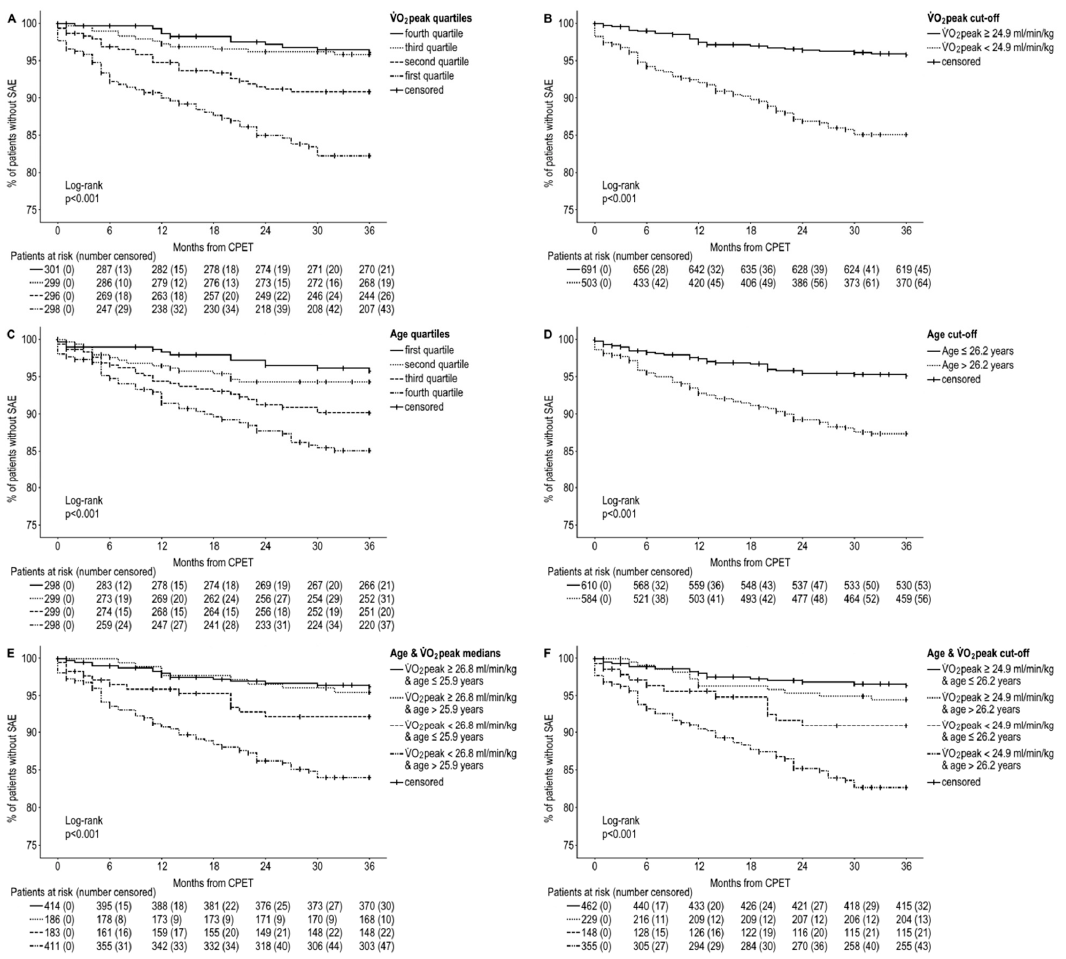
Figure 1. Kaplan–Meier SAE-free survival for V ̇ O 2 peak and age. ( A ) Kaplan–Meier SAE-free sur- . ROC cut-off value for VO 2 peak (24.9 mL/min/kg), ( C ) Kaplan–Meier SAE-free survival for quartiles of age at CPET, ( D ) Kaplan–Meier SAE-free survival for patients exceeding or not exceeding the ROC cut-off value for age (26.2 years) at CPET, ( E ) Kaplan–Meier SAE-free survival separated by medians . of age and VO 2 peak, ( F ) Kaplan–Meier SAE-free survival separated by ROC cut-off values for age at . CPET (26.2 years) and VO 2 peak (24.9 mL/min/kg); SAE: Severe arrhythmic event,